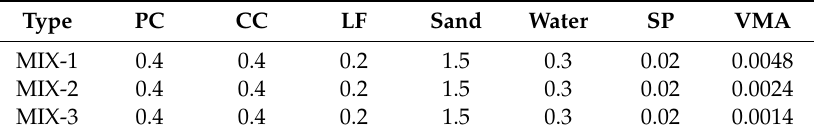
Figure 2. Particle size distribution analysis of dry components. Table 2. Mix designs of the fresh mortar for extrusion by mass ratio to the binder (the binder by mass—Portland cement (PC) + calcined clay (CC) + limestone filler (LF) = 1; the content of PC—331 kg / m 3